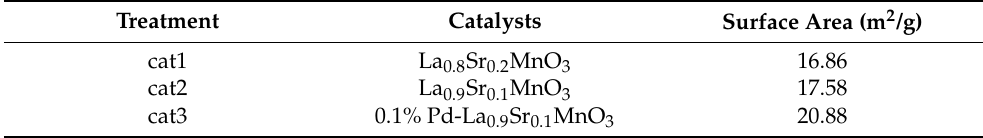
Table 1. Results of the BET specific surface curves of each